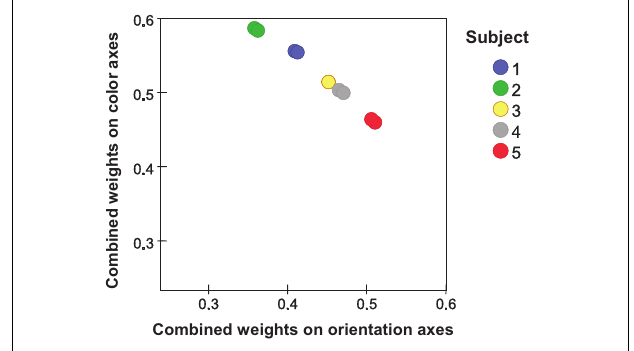
FIGURE 5 | Individual values from MDS (two values per subject) for the combined weights of orientation dimensions ( w q 12 + w q 22 ) plotted against the combined weights of color dimensions ( w q 32 + w q 42 + w q 52